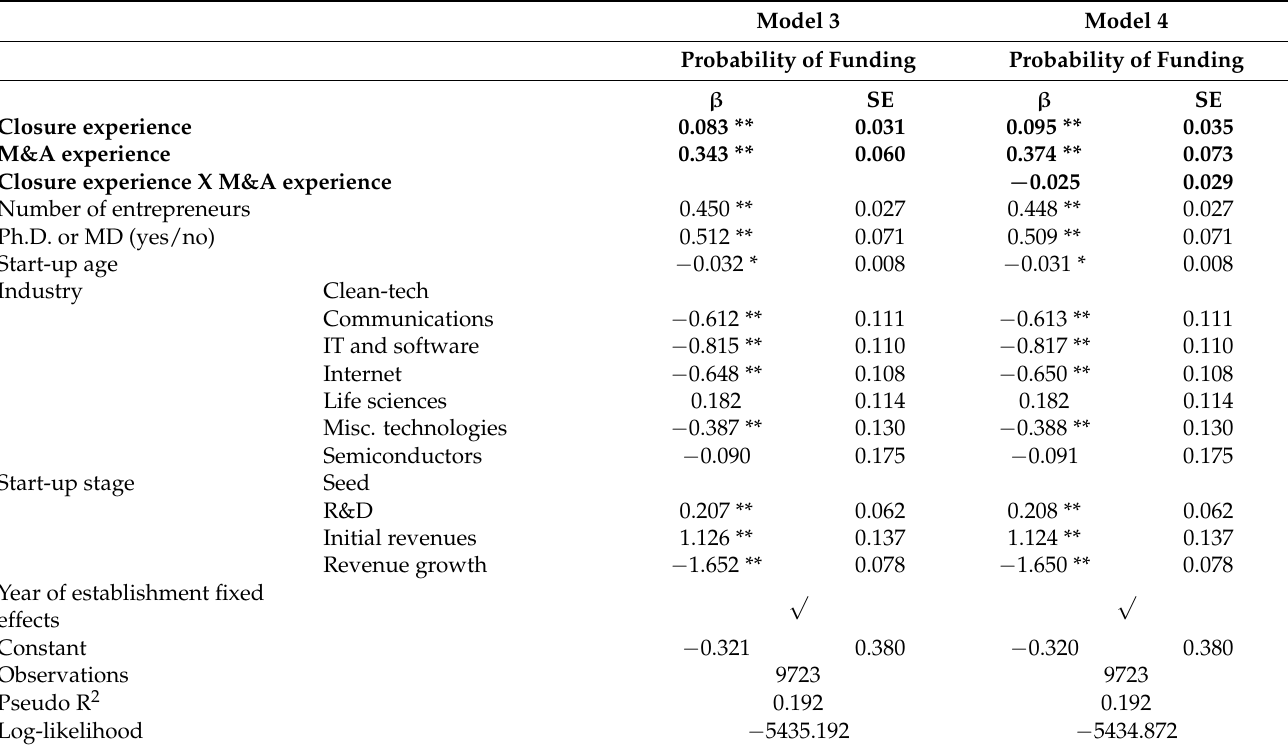
Table 3. The effect of entrepreneurs’ experience on the probability of